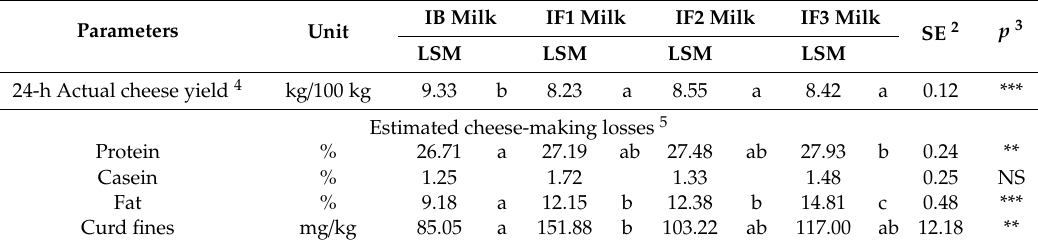
Table 4. Least square mean (LSM) values of 24-h actual cheese yield, estimated cheese-making losses and curd fines of cheese made from Italian Brown (IB) or Italian Friesian (IF1, IF2, IF3). Results of 12 Parmigiano Reggiano cheese-making trials 1